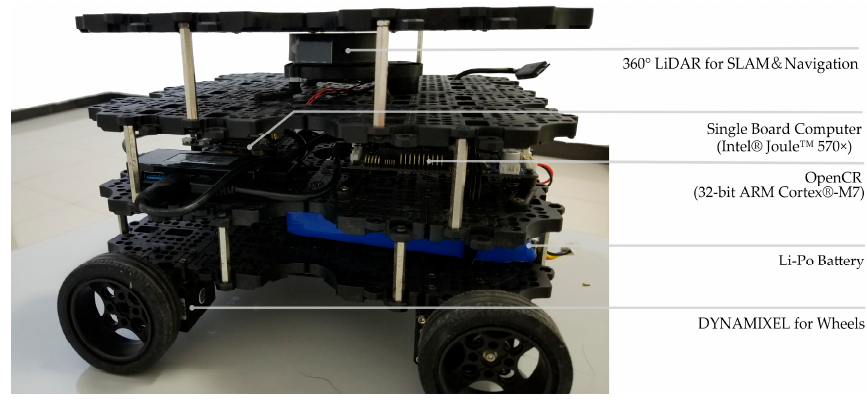
Figure 11. Experimental platform.